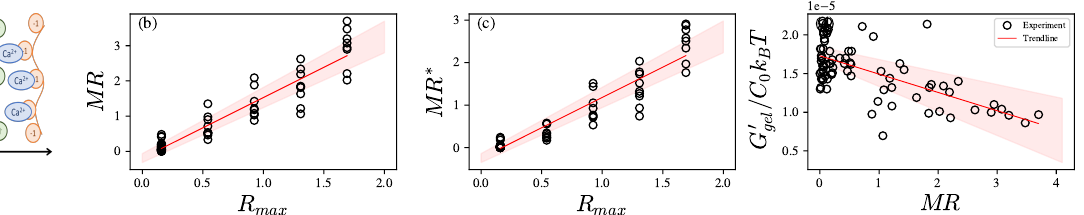
Figure 5. ( a ) A schematic to illustrate the decoupled bindings due to excess calcium salt. ( b , c ) show the molar ratios of free ions and bound sites at t = t gel ( MR ) and at t = t ∗ ( MR ∗ ) show a linear relationship with calcium concentration. ( d ) The linear dependence of normalized storage modulus at t = t gel , G (cid:48) / C 0 k B T , on MR .The red shadows show the influence of the slope uncertainties gel within 2.5 standard errors. The standard errors for the slopes are ( b ) 6.43 × 10 − 2 , ( c ) 5.36 × 10 − 2 , and ( d ) 3.11 × 10 − 7 . The standard errors for the intercepts are ( b ) 4.99 × 10 − 2 , ( c ) 4.15 × 10 − 2 , and ( d ) 3.86 × 10 − 7